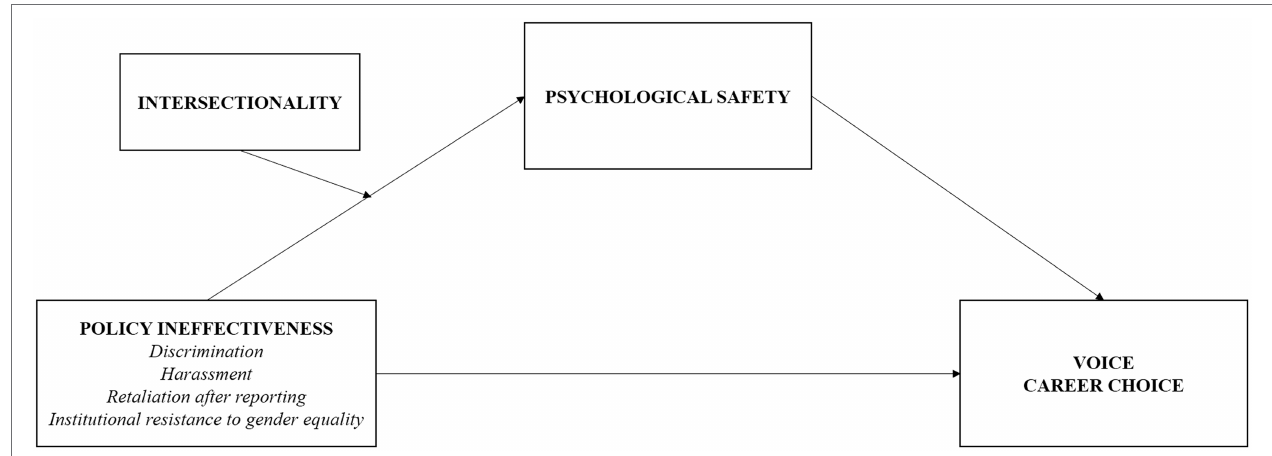
FIGURE 1 | Conceptual model tested in this